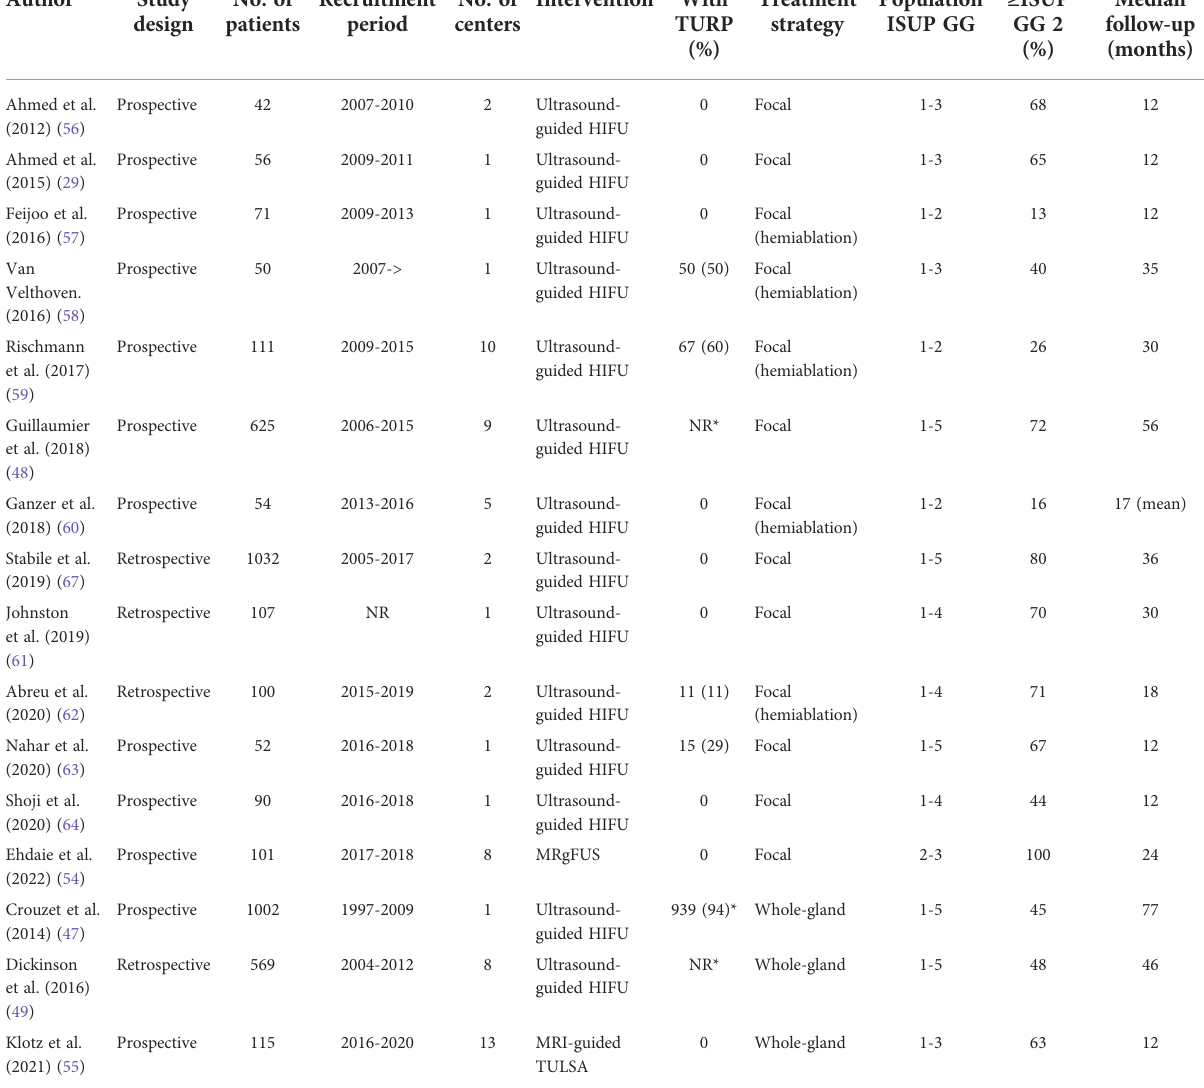
TABLE 2 Prospective and largest retrospective studies evaluating ultrasound ablation of primary localized prostate